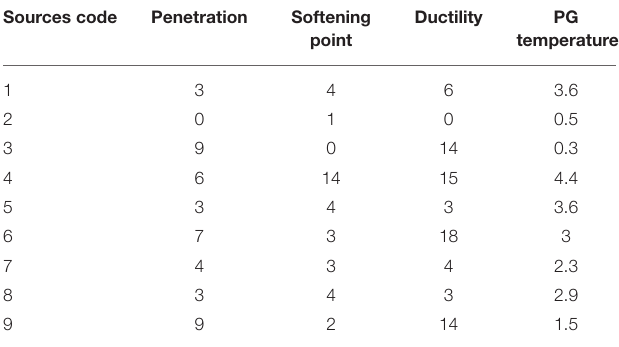
TABLE 4 | Result of absolute difference.